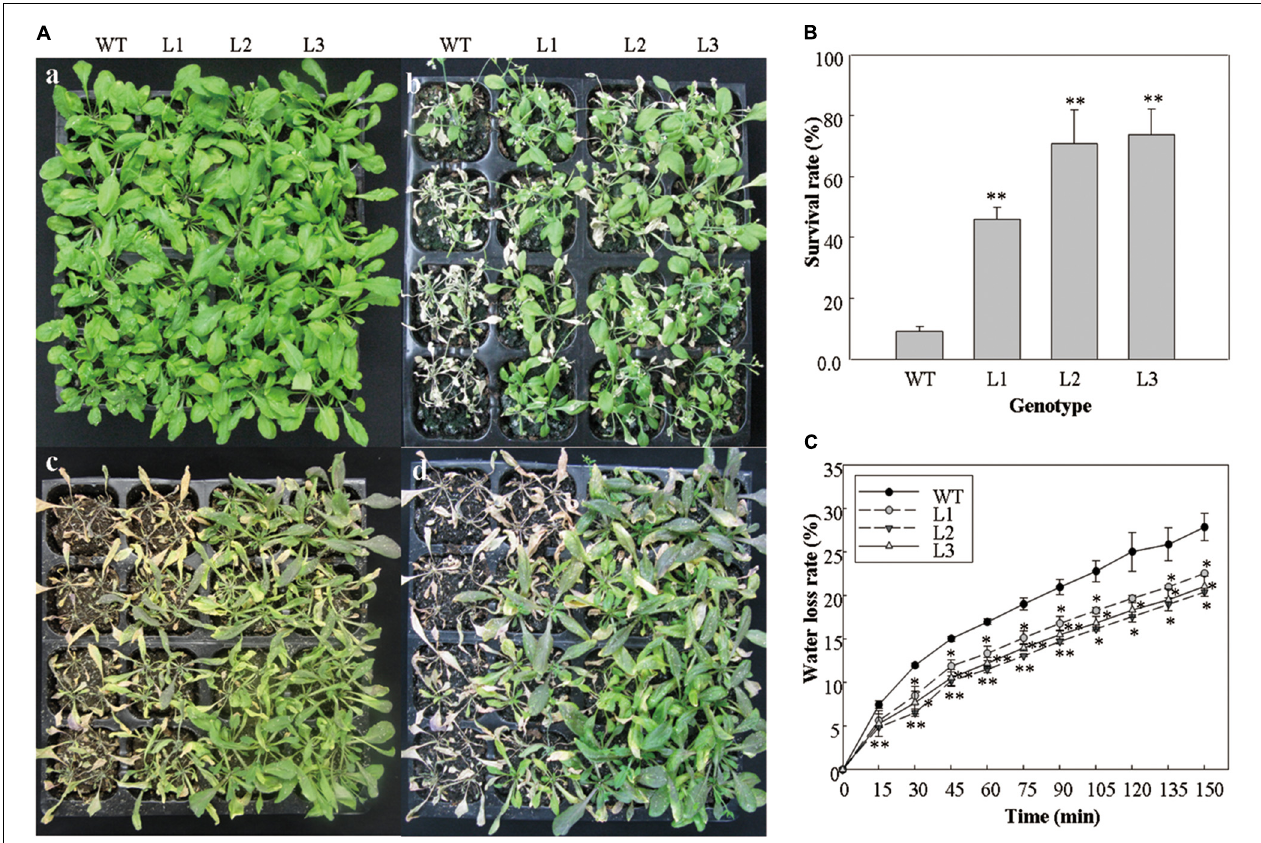
FIGURE 3 | Performance of WT and VlWRKY3 transgenic Arabidopsis thaliana plants under normal growth and abiotic stress conditions. (A) Representative images of 5-week-old potted WT and transgenic plants under normal growth and abiotic stress conditions. (a) WT and transgenic plants grown for 5 weeks under normal condition. (b) Five-week-old WT and transgenic plants that were treated with 200 mM NaCl for 7 days. (c) Five-week-old WT and transgenic plants that were deprived of water for 7 days. (d) WT and transgenic plants that were deprived of water for 7 days and then re-watered. (B) Survival rates of WT and transgenic lines 24 h after re-watering. Each data point is the mean of three replicates of 32 plants. (C) Water loss rate of detached leaves of WT and transgenic plants. Each data point is the mean of three replicates of 10 detached leaves. In (B,C) , the error bars indicate the SD, Asterisks indicate statistical significance ( ∗ 0.01 < P < 0.05, ∗∗ P < 0.01, Student’s t -test) of differences between transgenic lines and